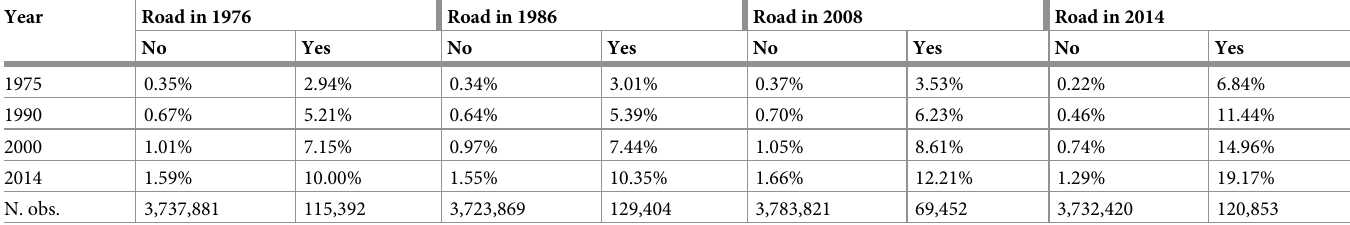
In Table 4 we break down y by agro-ecological zone and proximity to borders and water. it We find strong initial differences in buildup density across zones with, in 1975, more buildings (and hence a higher population density) in semi-humid areas and in areas with humid or hydromorphic soils. Over the study period, however, we observe dramatic changes in relative buildup densities: cells with initially the lowest buildup densities—i.e., areas with soils that are humid, hydromorphic, or waterlogged or steep—experience the fastest growth, possibly sug- gesting that investments were successful in making these soils or locations more productive. Reduction in onchocercosis—also known as river blindness—may have also attracted settle- ment in these areas. Table 5 presents a similar breakdown of built-up areas by the presence or not of a road in the cell. Not surprisingly, we find a strong difference in buildup density between cells with and without a road. This difference falls over time however: comparing cells with and without a road in 1976, the difference falls from 8.5 more buildup in 1975 to 6.3 times in 2014. We also note that the new road definitions adopted in the 2014 data match heavily built-up areas much more closely than before, suggesting that this new road nomenclature puts more emphasis on residential streets [57] and lesson dirt roads serving rural communities. In Table 6 we show buildup proportions in ‘edge cells’, that is, cells that overlap with a land border or a water body. We see that the presence of a water body is in general associated with a Table 5. Breakdown of built-up proportion by presence of a road.